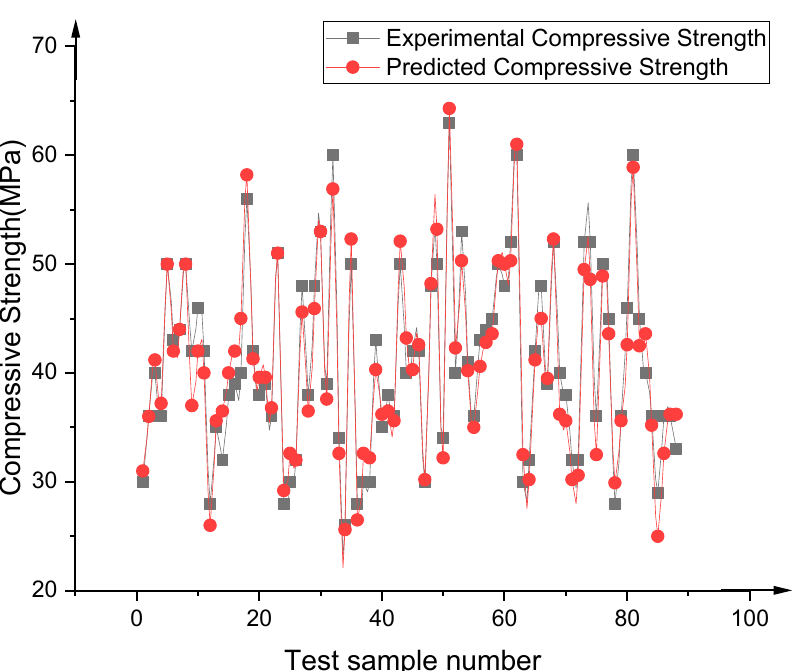
Figure 26. Comparison between prediction values and test values of RAC compressive strength (test data).